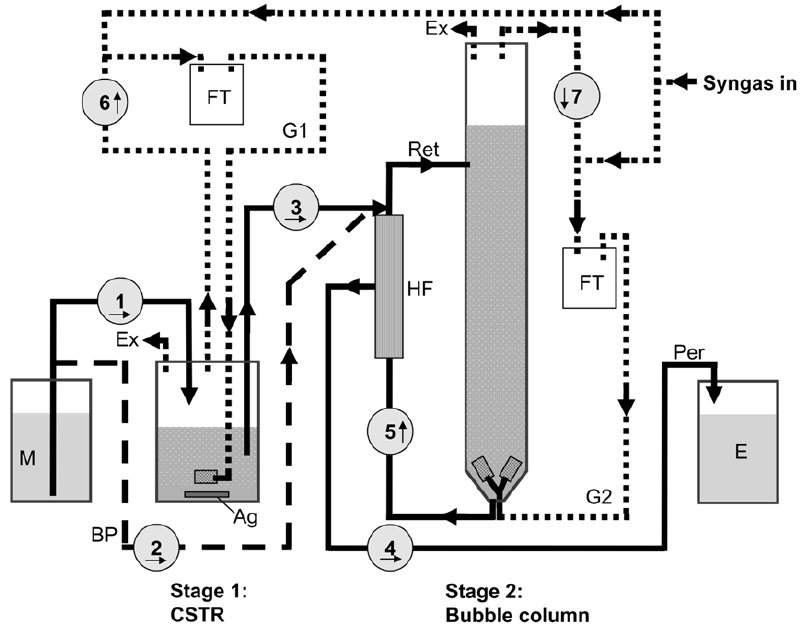
Figure 3. Setup of two-stage continuous fermentation with cell and gas recycle. Solid lines: flow of liquid media; dotted lines: flow of substrate and exhaust gases. Abbreviations: 1–7 pumps; Ag, agitation; BP, bypass; E, effluent reservoir; Ex, exhaust; FT, foam trap; G1, G2, gas recycle loops; HF, hollow fiber module for cell recycle; M, media reservoir; Per, permeate; Ret,